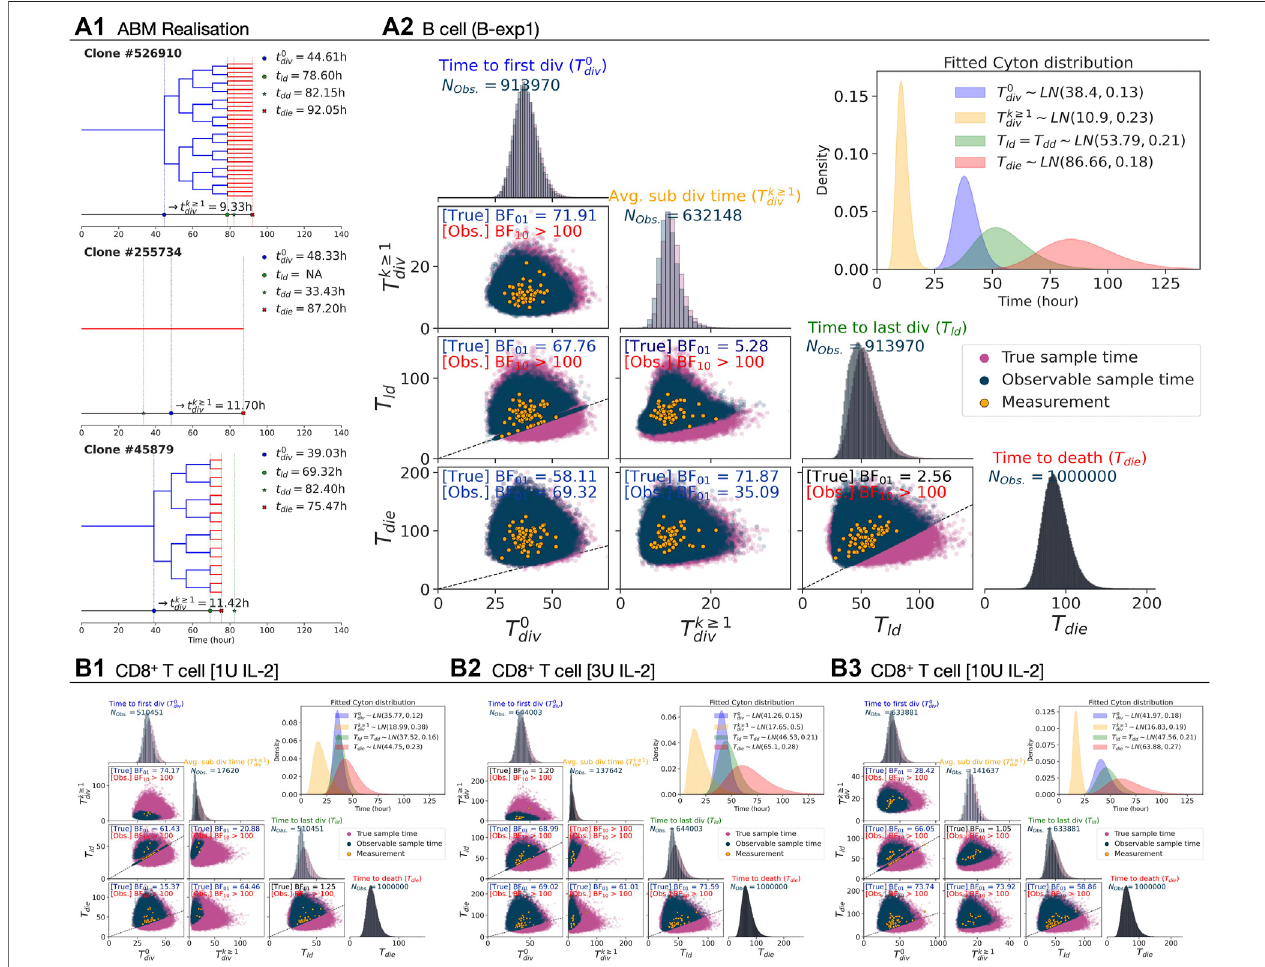
FIGURE 3 | Simulation under the independence assumption. 10 6 Cyton2 families were simulated given fi tted lognormal distributions of T 0 div , T k ≥ 1 div , T ld , T die from respective fi lming datasets. (A1) Three example ABM families parameterised as CpG-stimulated B cells: dividing (blue solid-line) and dying (red solid-line) states. The (cid:129) (cid:129) realisations of T 0 div ( ), T k ≥ 1 div ( t k ≥ 1 div ), T ld ( ), T dd ( + ) and T die ( × ) are annotated on a collapsed line. As a feature of inheritance, the progeny cells double in number synchronously whenever division occurs, and likewise, they reach destiny and death at the same time. (A2, B1 – B3) For all simulated families, each variable was randomly sampled from the fi tted Cyton distribution (inset), and the samples are labeled as true sample time (purple dot). Their corresponding observable sample times (bluedot) areshown alongwiththe datapoints (orange dot) from the fi lmingdatasets.Distributionsofthe sampled true and observable times ofeach variable areshown in the diagonal panels. The observable and unobservable regions are separated by upper and lower sections of y (cid:2) x line (dashed-line), respectively. The Bayes factors are reported for the true and observable pairs.